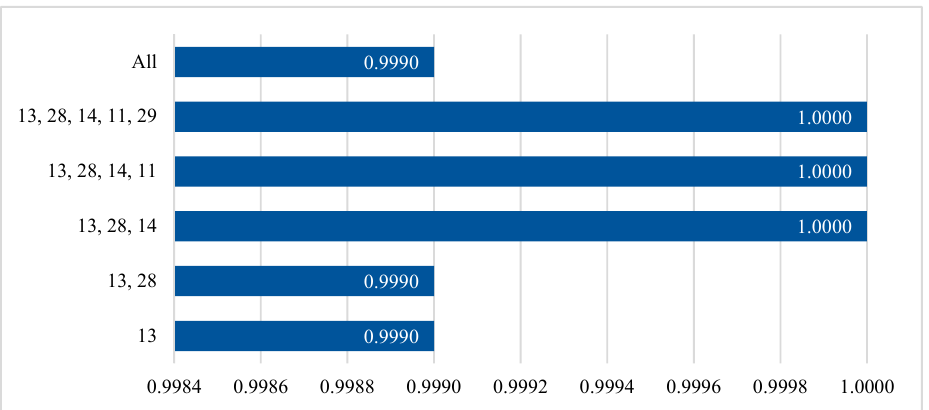
Figure 8. Accuracy results for the testing set with different numbers of features when detecting Mirai, Bashlite, and benign classes.